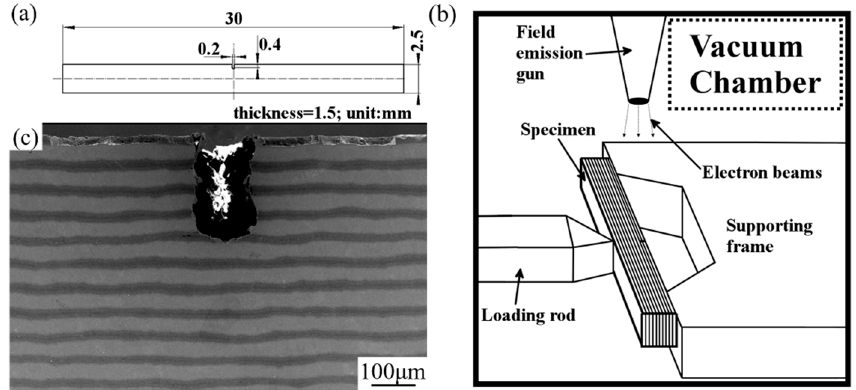
Figure 3. ( a ) Dimensions of the examined sample, ( b ) schematic illustration of the experimental stage in a vacuum chamber, and ( c ) initial morphologies of the area near the notch of the sample.